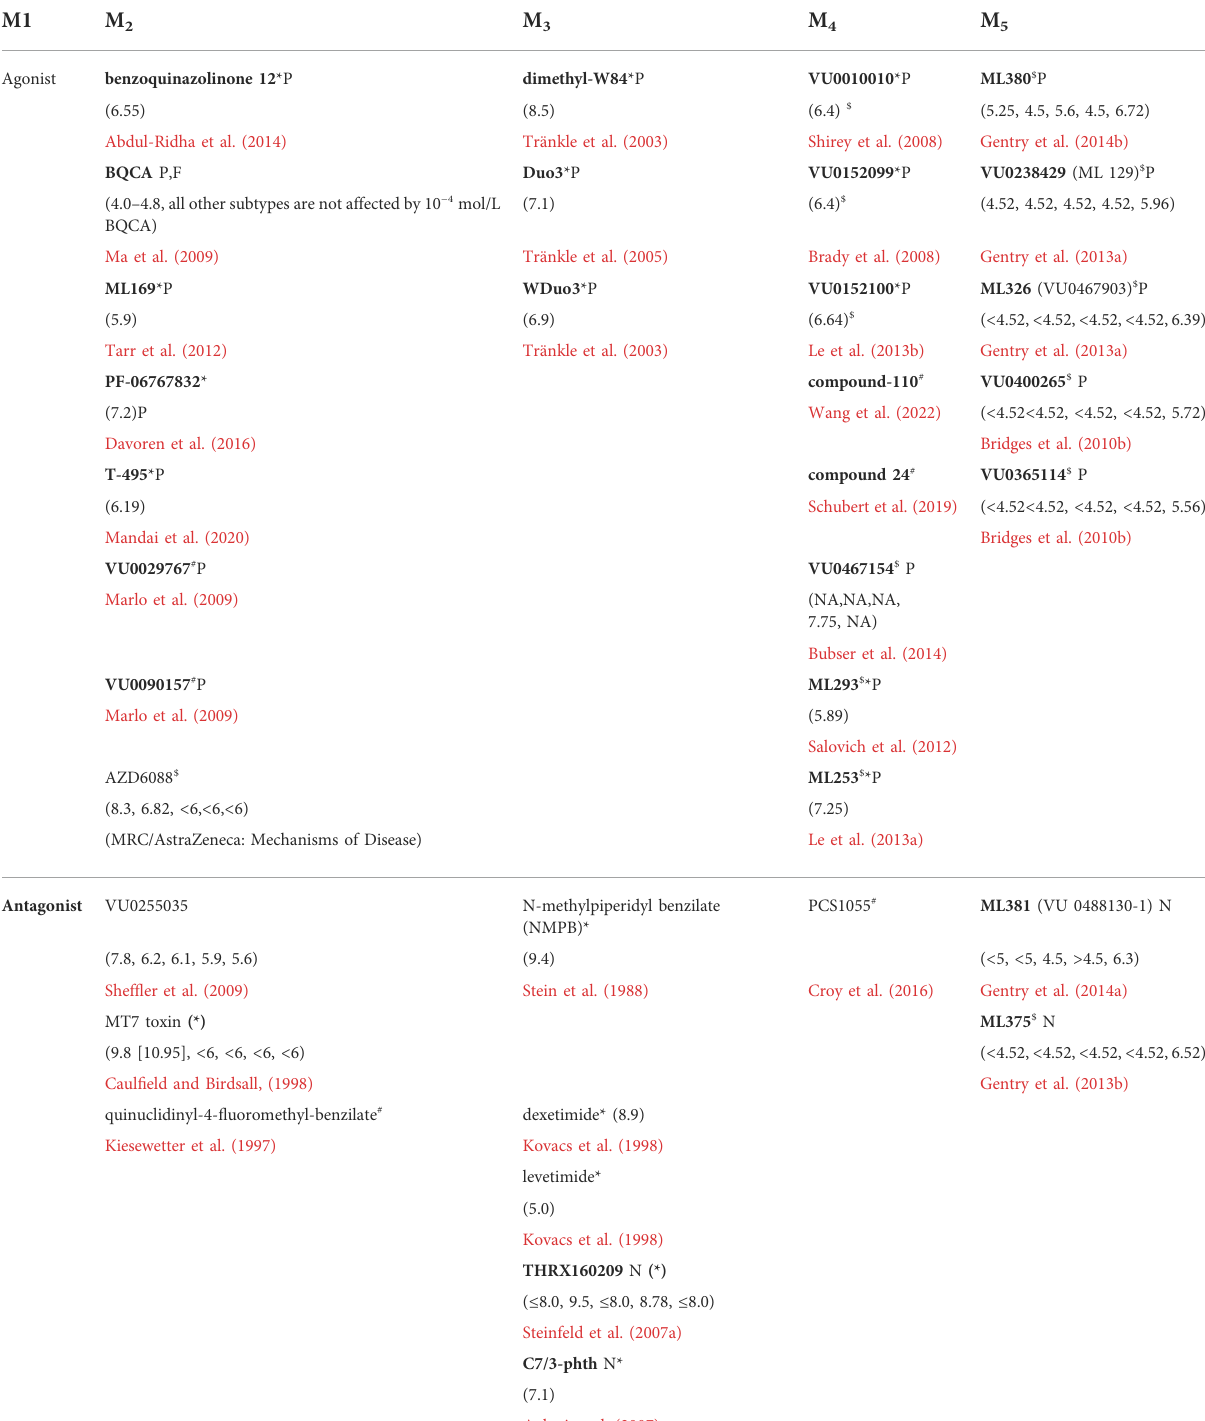
TABLE 4 The list of selective MR ligands. The present state of knowledge. The values in parentheses represent pK i (pK D , respectively) for M 1 , M 2 , M 3 , M 4 , and M 5 MRs). Some orthosteric agonists ((-)YM796, AZD6088, LSN3172176, butylthio-TZTP are not suf fi ciently documented with respect to selectivity. The same can be stated about allosteric agonist listed in this table (ML169, PF-06767832, T-495) that have been reported as selective